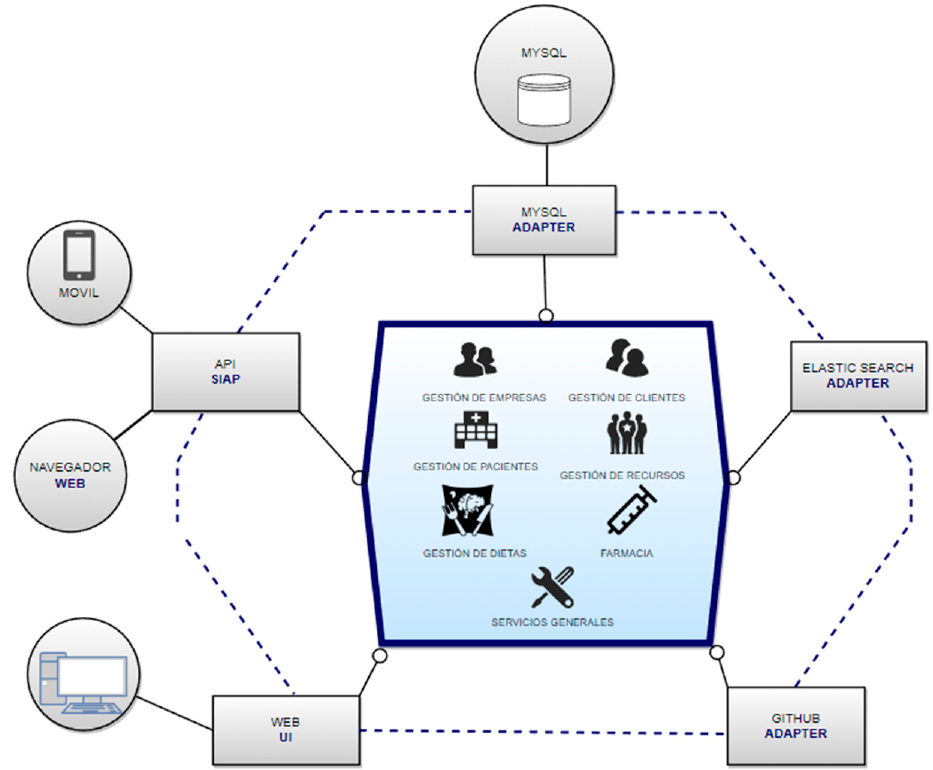
Figure 7. SIAP Hexagonal Platform Architecture.